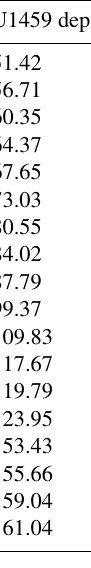
Table A2. A minor chronology adjustment of Site 763 compared to Karas et al. (2011a) was needed in the youngest part of the